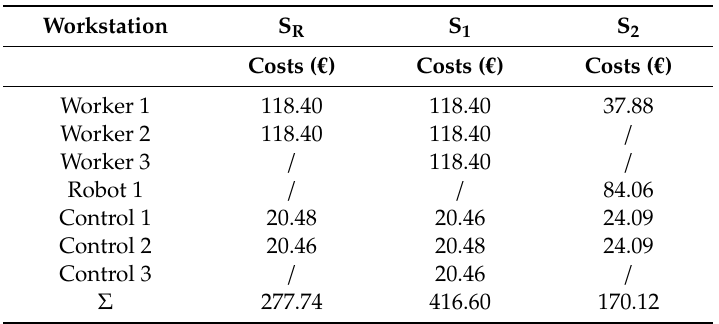
Table 4. Simulation scenarios result presenting workplace costs’ evaluation.